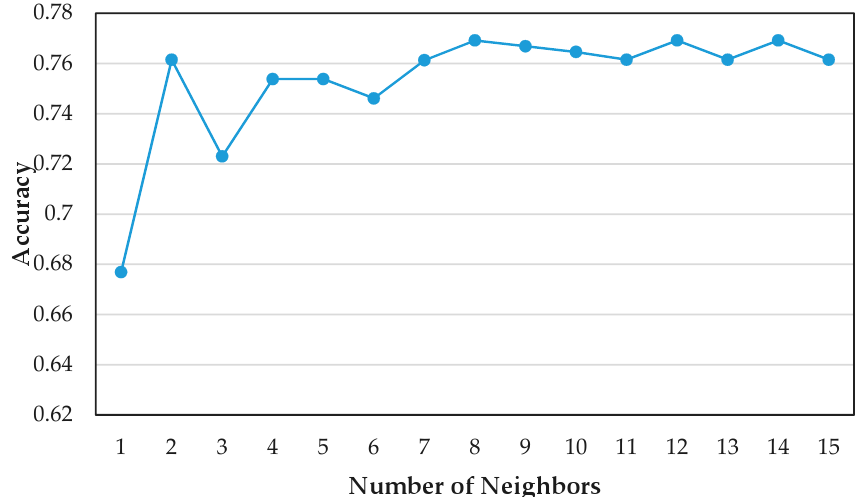
Figure 11. Selection of parameters for the random forest model.